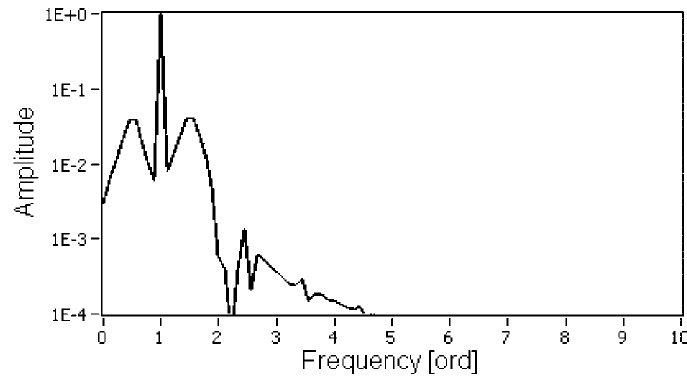
Fig. 14. Order spectrum for a varying sinusoidal acceleration and a spline interpolation of the shaft angular position.